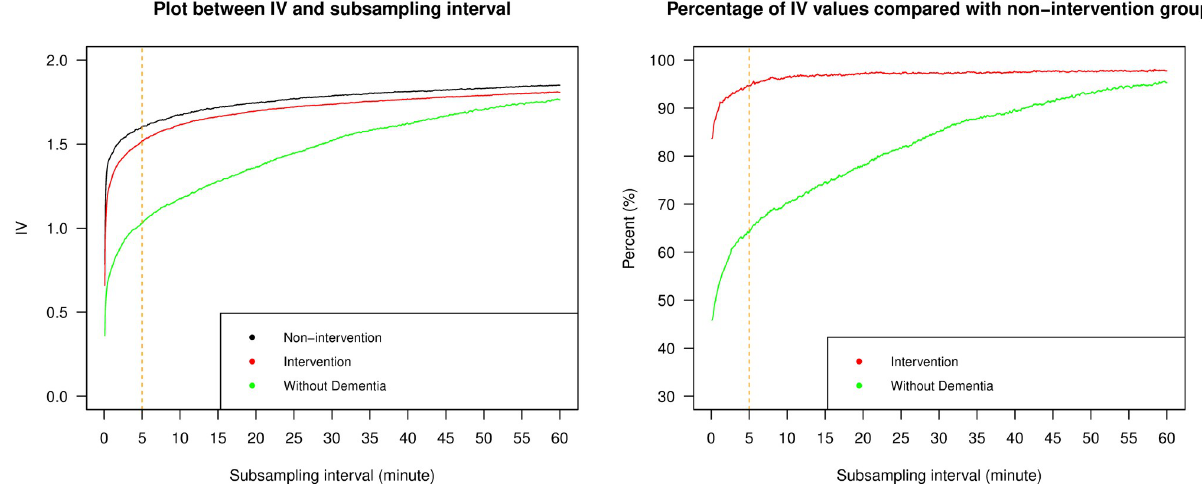
Fig 3. Intradaily variability (IV) vs. subsampling interval. The left panel displays line plots of average IV values against the subsampling interval for the three different groups of individuals; the right panel displays line plots of the percentage of average IV values from the intervention group and the group of individuals without dementia, compared with those from the non-intervention group. The orange dashed line refers to 5 minutes and indicates our recommended subsampling